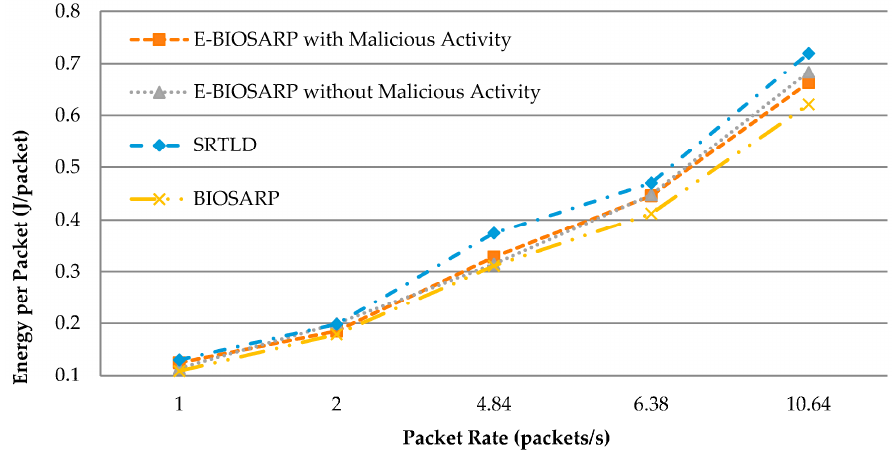
Figure 12. Energy consumption comparison.